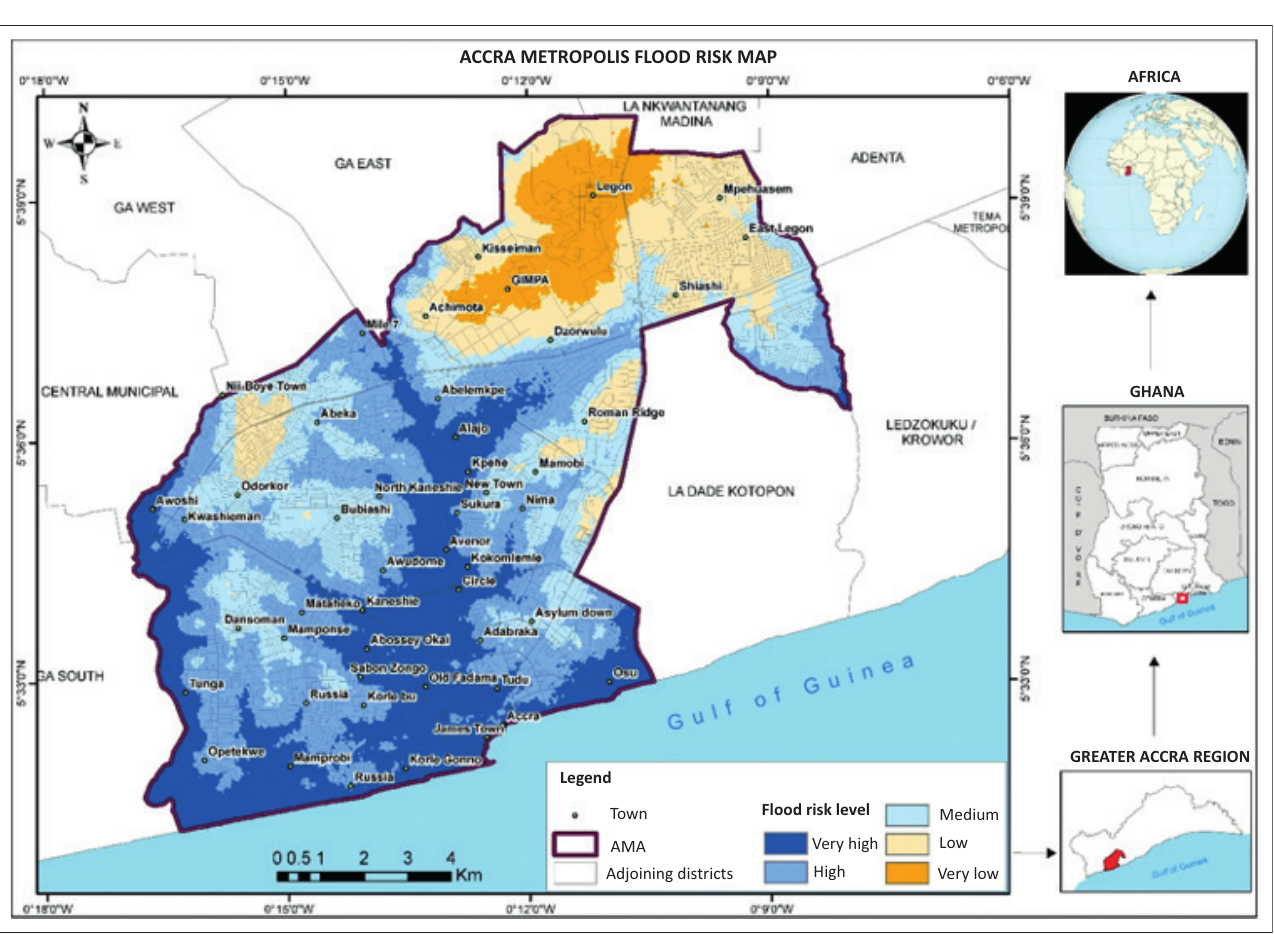
FIGURE 4: Flood-risk zones of the study area.